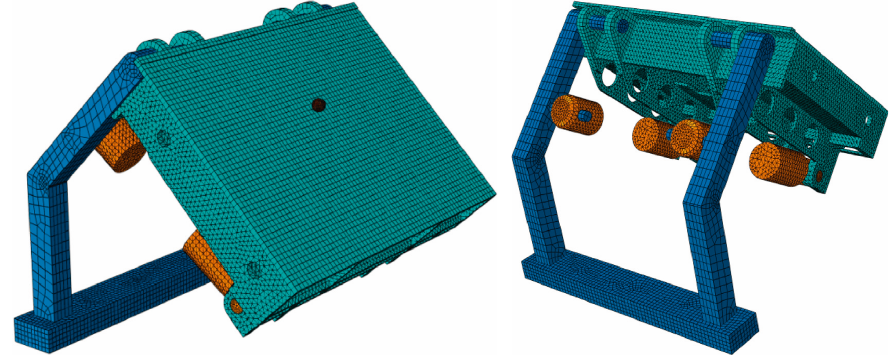
Figure 10: Simulation model after